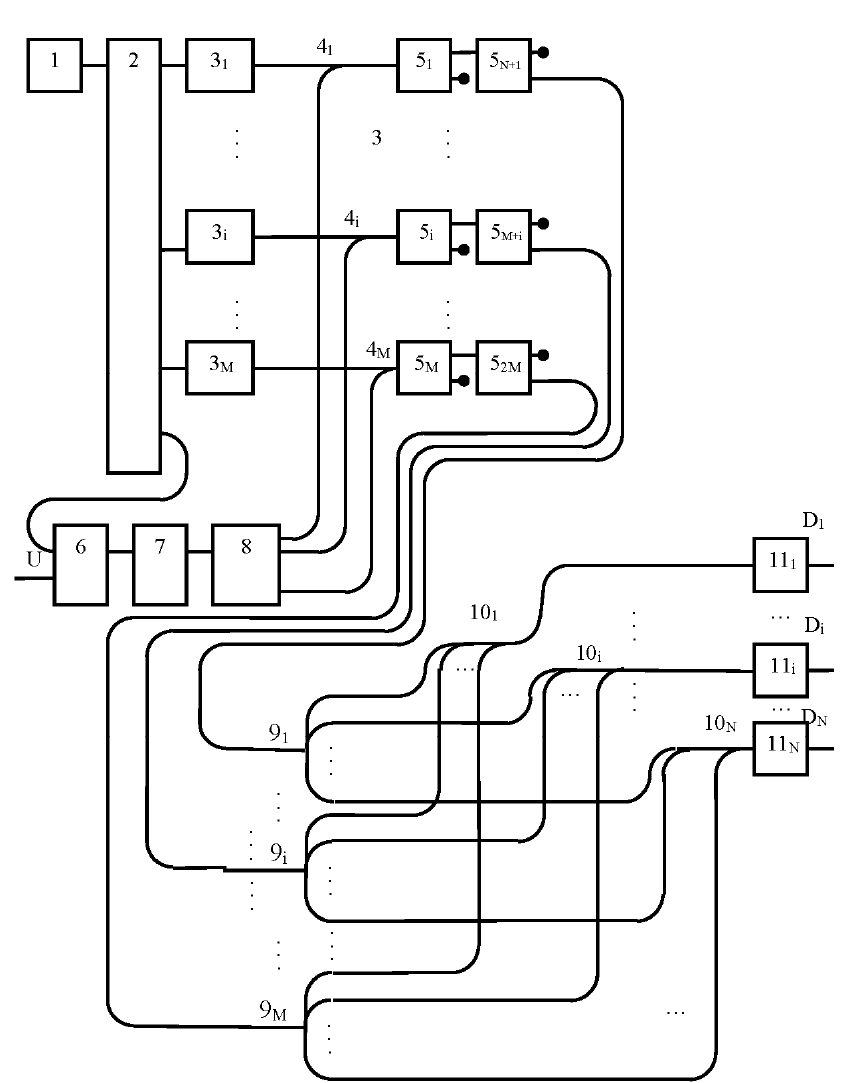
Figure 1. Function diagram of the analog-to-digital converter.